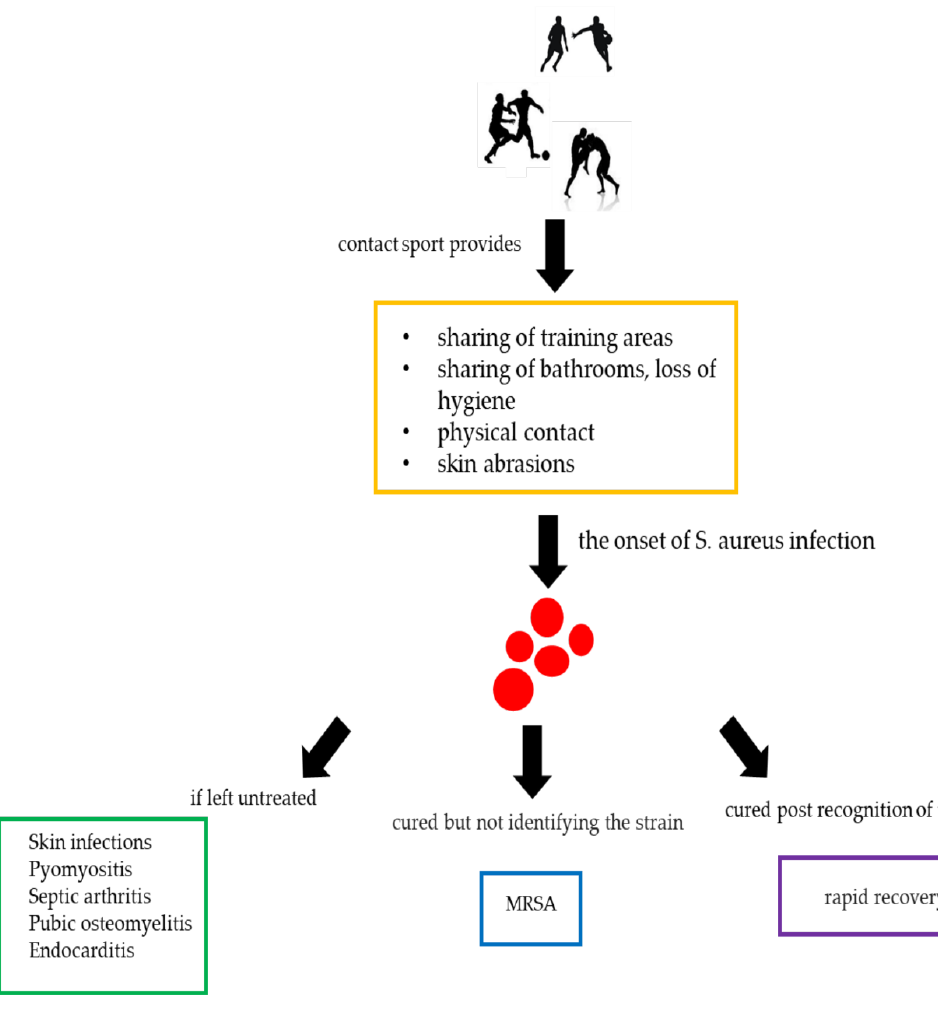
Figure 7. Contact sports and Staphylococcus aureus.